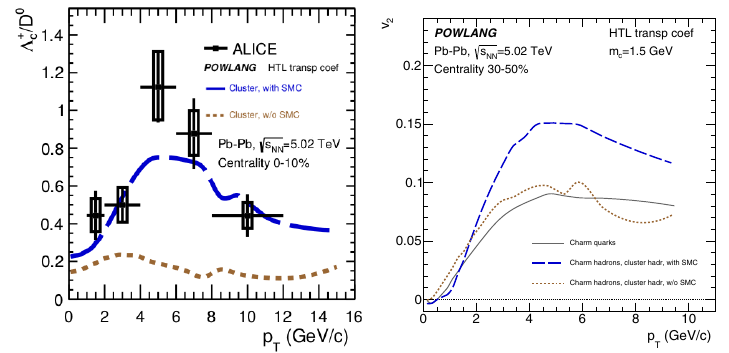
Figure 4. Charmed hadron ratios (left panel) and elliptic flow (right panel) with (dashed blue curves) and without (dotted brown curves) space-momentum correlation, the last case being obtained mixing momentum and position of heavy quarks from di ff erent events at